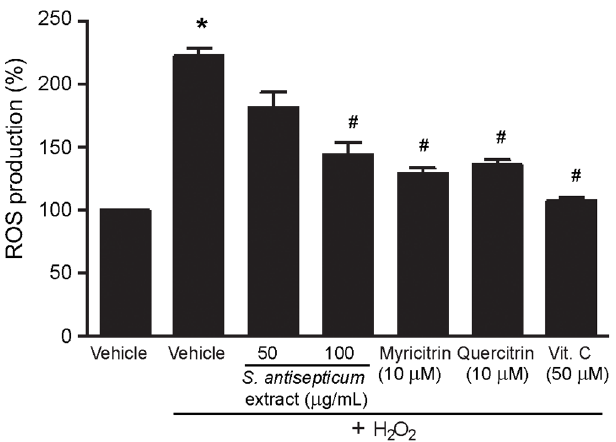
Figure 3. Cellular antioxidant effects of the methanol (MeOH) extract and flavonoid glycosides 7 and 8 from S. antisepticum ; HEK-293 cells were treated with either methanol extract (50 and 100 µg/mL), myricitrin ( 7 ) (10 µM), quercitrin ( 8 ) (10 µM), or vitamin C (10 µM) for 3 h and then treated with H 2 O 2 (100 µM) for 1 h. Data are shown as the percentage of ROS levels (mean ± SEM) as compared with that in control (vehicle; DMSO) group (n = 4). * p < 0.05 versus control; # p < 0.05 versus the H 2 O 2 group.